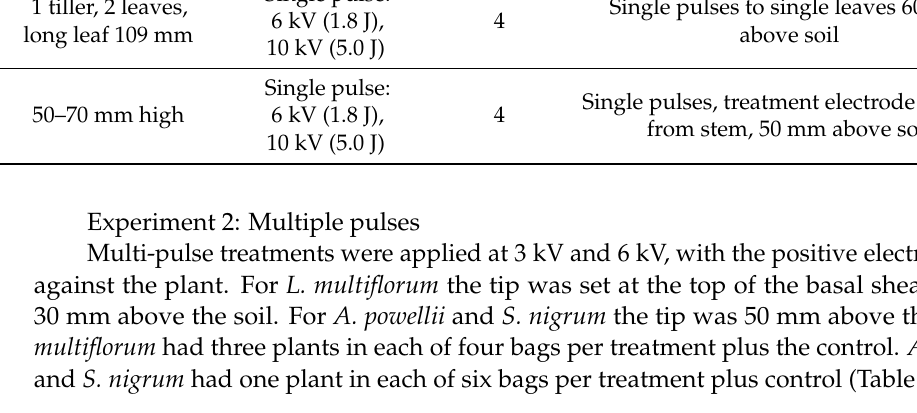
Table 2. Trial summary table showing trial number, weed species, plant size, multiple electric pulse treatments applied and number of